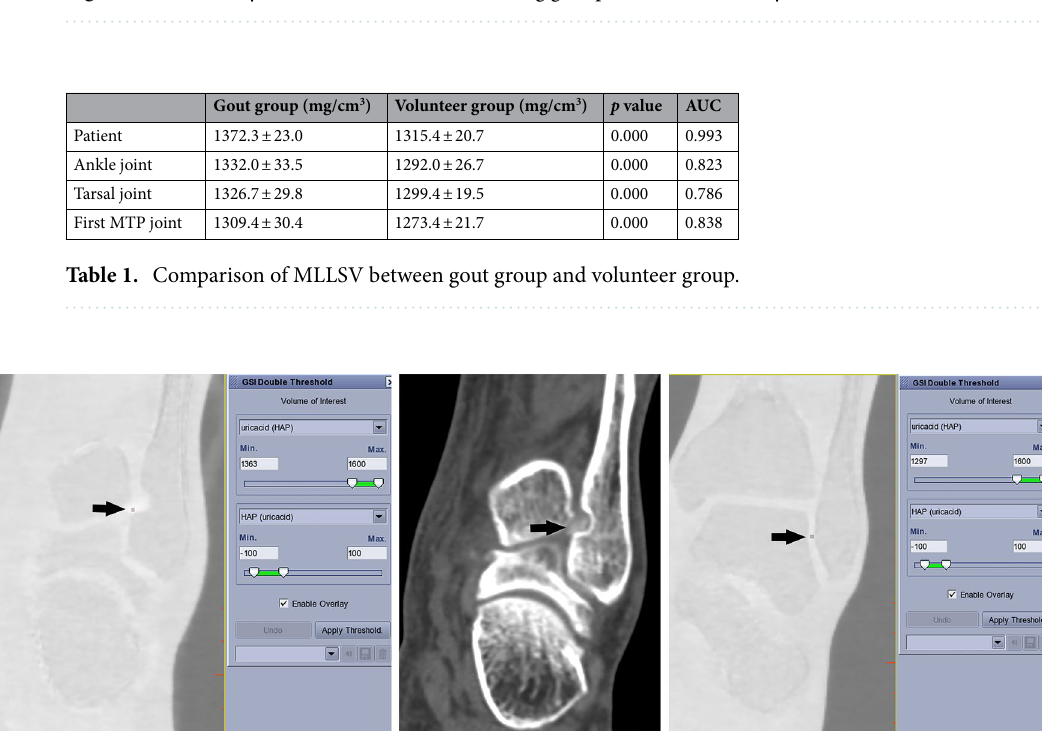
Figure 4. ROC analysis of MLLSV for discriminating gout patients from healthy volunteers. AUC is 0.993.